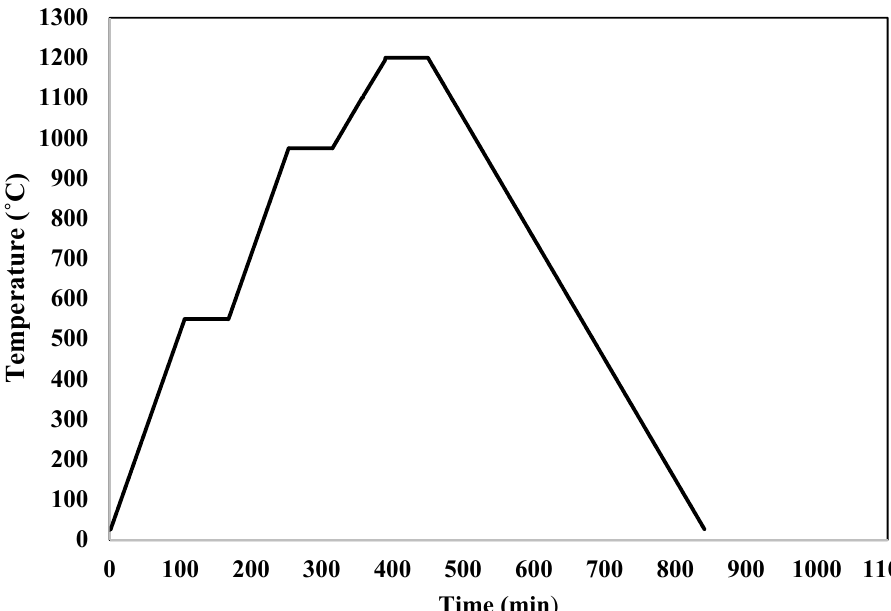
Figure 2. Variation of temperature over time during sintering membranes.